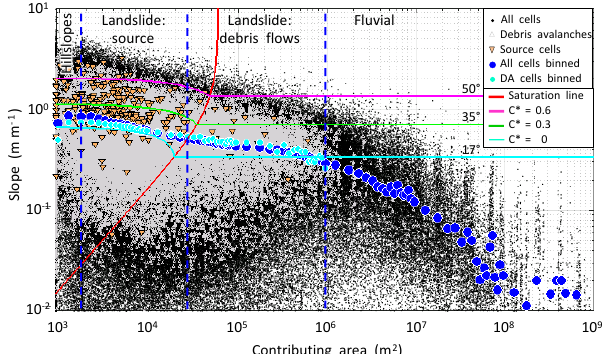
Figure 5. Slope-contributing area ( S –CA) log–log plot for North Cascades National Park Complex. Mean S for bins of CA are indi- cated by blue dots and cyan dots for all cells and debris avalanche (DA) cells, respectively. DA source cells (orange triangles) are the single highest-elevation grid cell within mapped debris avalanches (gray). Horizontal slope stability curves plot the solution of S (Eqs. 1a and 2) as a function of CA, given FS = 1, R/T = 0.0005, ∅ = 34 ◦ and select values of dimensionless cohesion, C ∗ ; S for horizontal line portion (fully saturated regions) are labeled in ◦ for ease of understanding. Above each curve landscape is unstable for a given C ∗ . Saturation line (red curve) separates partially saturated areas (left) from saturated areas (right). Blue vertical lines divide the plot into geomorphic process domains in relation to CA of the landscape (e.g., Montgomery, 2001). Cyan horizontal line at 17 ◦ generally separates potential landslide dominated areas from fluvial dominated